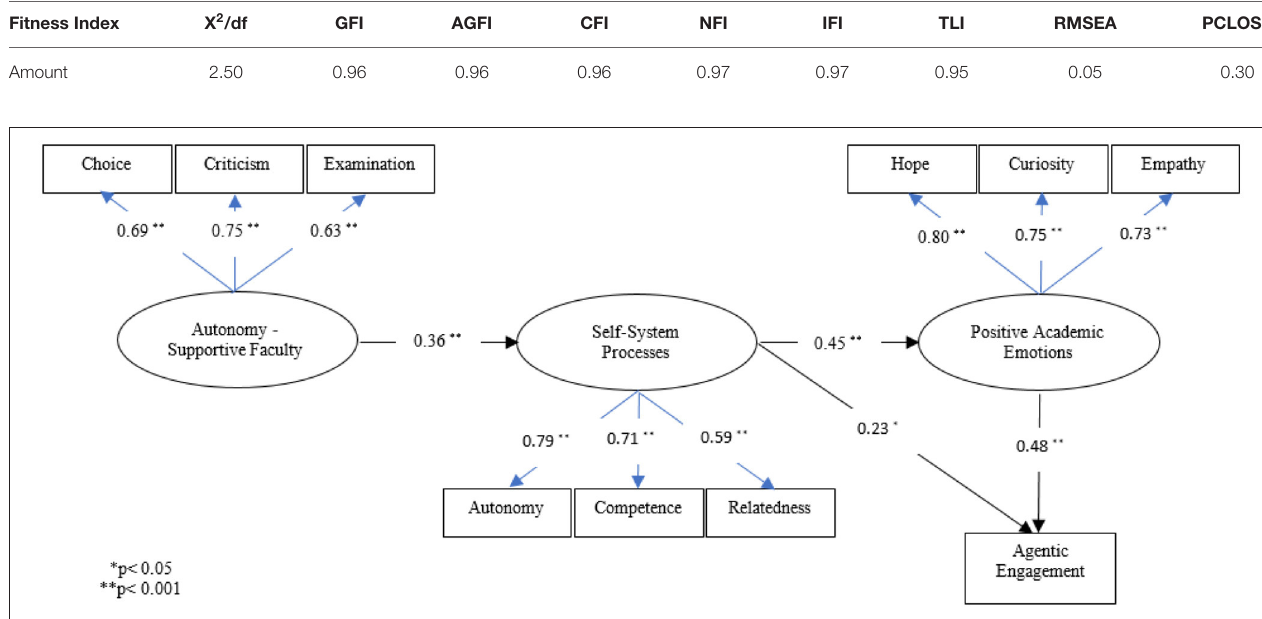
FIGURE 2 | Standardized regression weights in model.